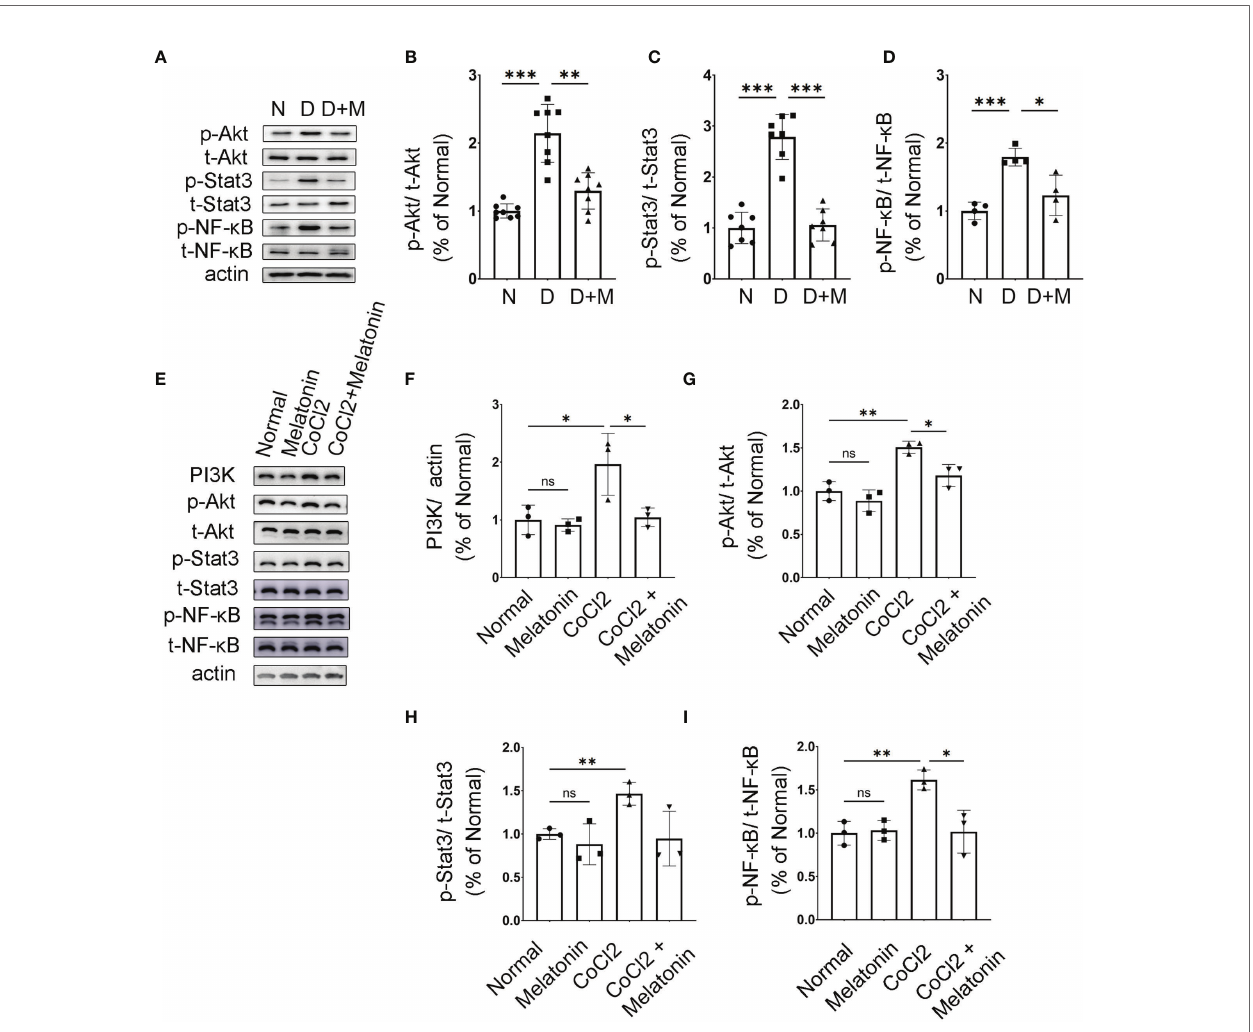
FIGURE 8 | Melatonin inhibits AKT and Stat3 signaling pathways in activated microglia. (A – D) The protein expressions of p-Akt, p-Stat3, and p-NF- k B in normal control and diabetic rat retinas with or without melatonin treatment. Data are expressed as mean ± SEM (n = 4 retinas per group). (E – I) The protein expressions of PI3K, p-Akt, p-Stat3, and p-NF- k B in the control group, control + melatonin group, CoCl 2 group, and CoCl 2 + melatonin group. Data are expressed as mean ± SEM (n = 3 retinas per group); *p < 0.05, **p < 0.01, ***p < 0.001 by one-way ANOVA. ns, non-signi fi cant